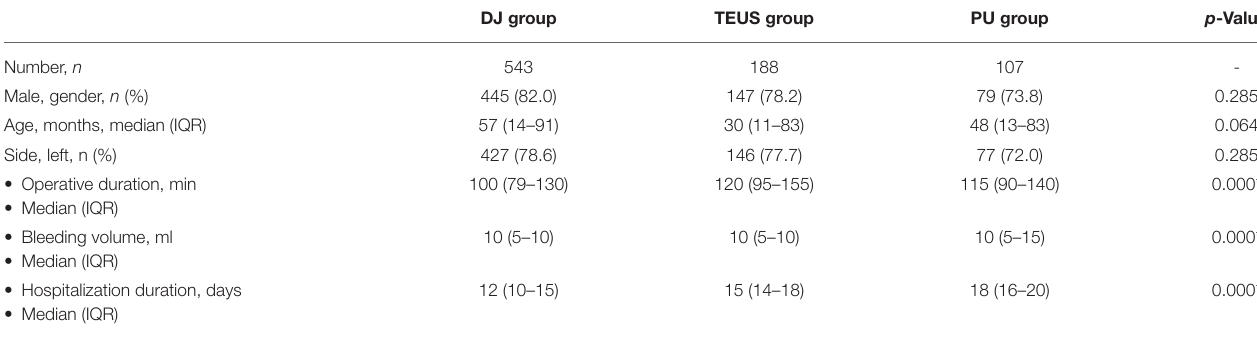
TABLE 1 | Patients’ demographics and data of operation.